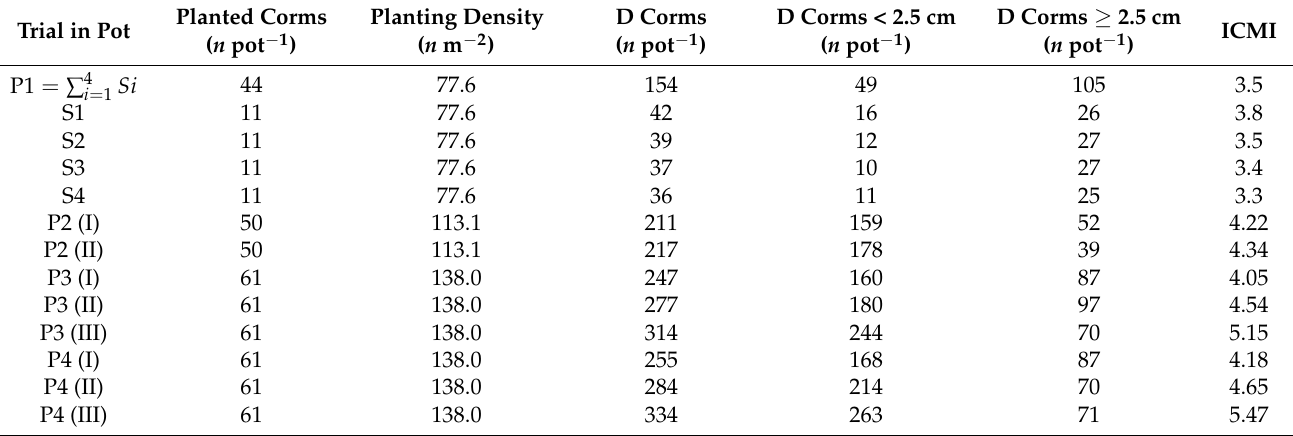
Table 5. Difference between daughter corms (D corms) from the trials in pots over the three consecu- tive growth seasons (P1, P2 and P3) and from different geographical origin (P3, P4).